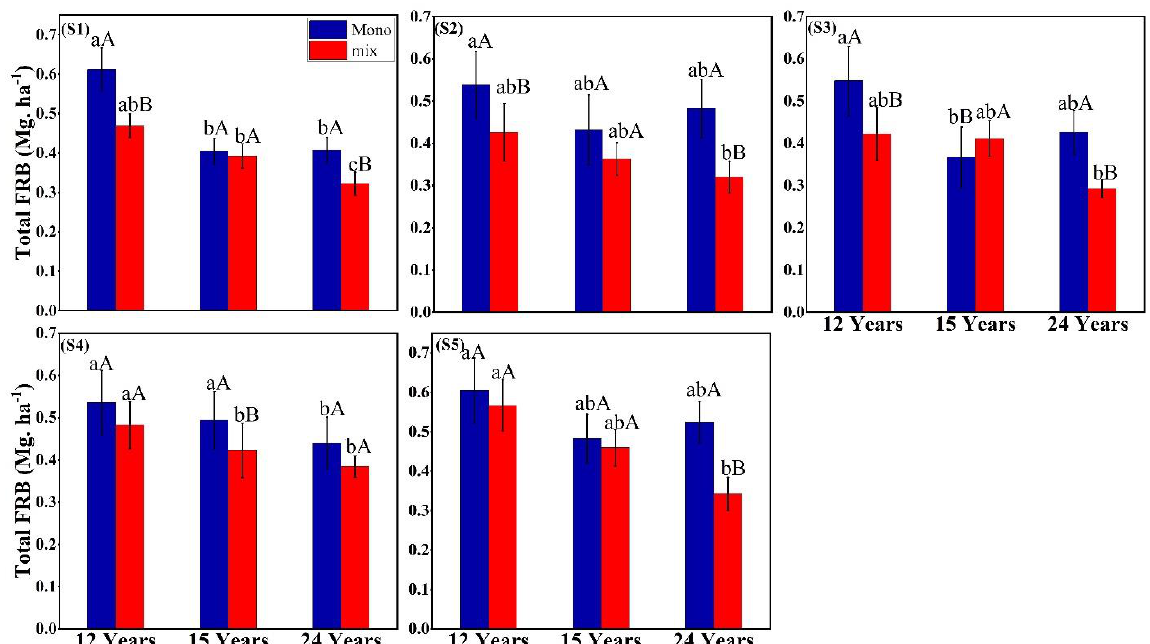
Figure 1. Total fine root biomass under different stand ages (12, 15, and 24 years) and seasonal intervals ((S1), March 2018; (S2), June 2018; (S3), September 2018; (S4), December 2018 and (S5), March 2019) in the two management systems, i.e., rubber monoculture (mono) and rubber- F. macrophylla intercropping (mix). The uppercase letters represent a significant difference between the two management systems, and the lowercase letters represent the significant difference between the three stand ages at p < 0.05 (mean ± SE, n = 3). Table 1. Linear mixed-effect model values attained testing effects of different management systems (M), stand age (A), seasons (S), and soil depths (D) on fine root biomass and available nutrients.